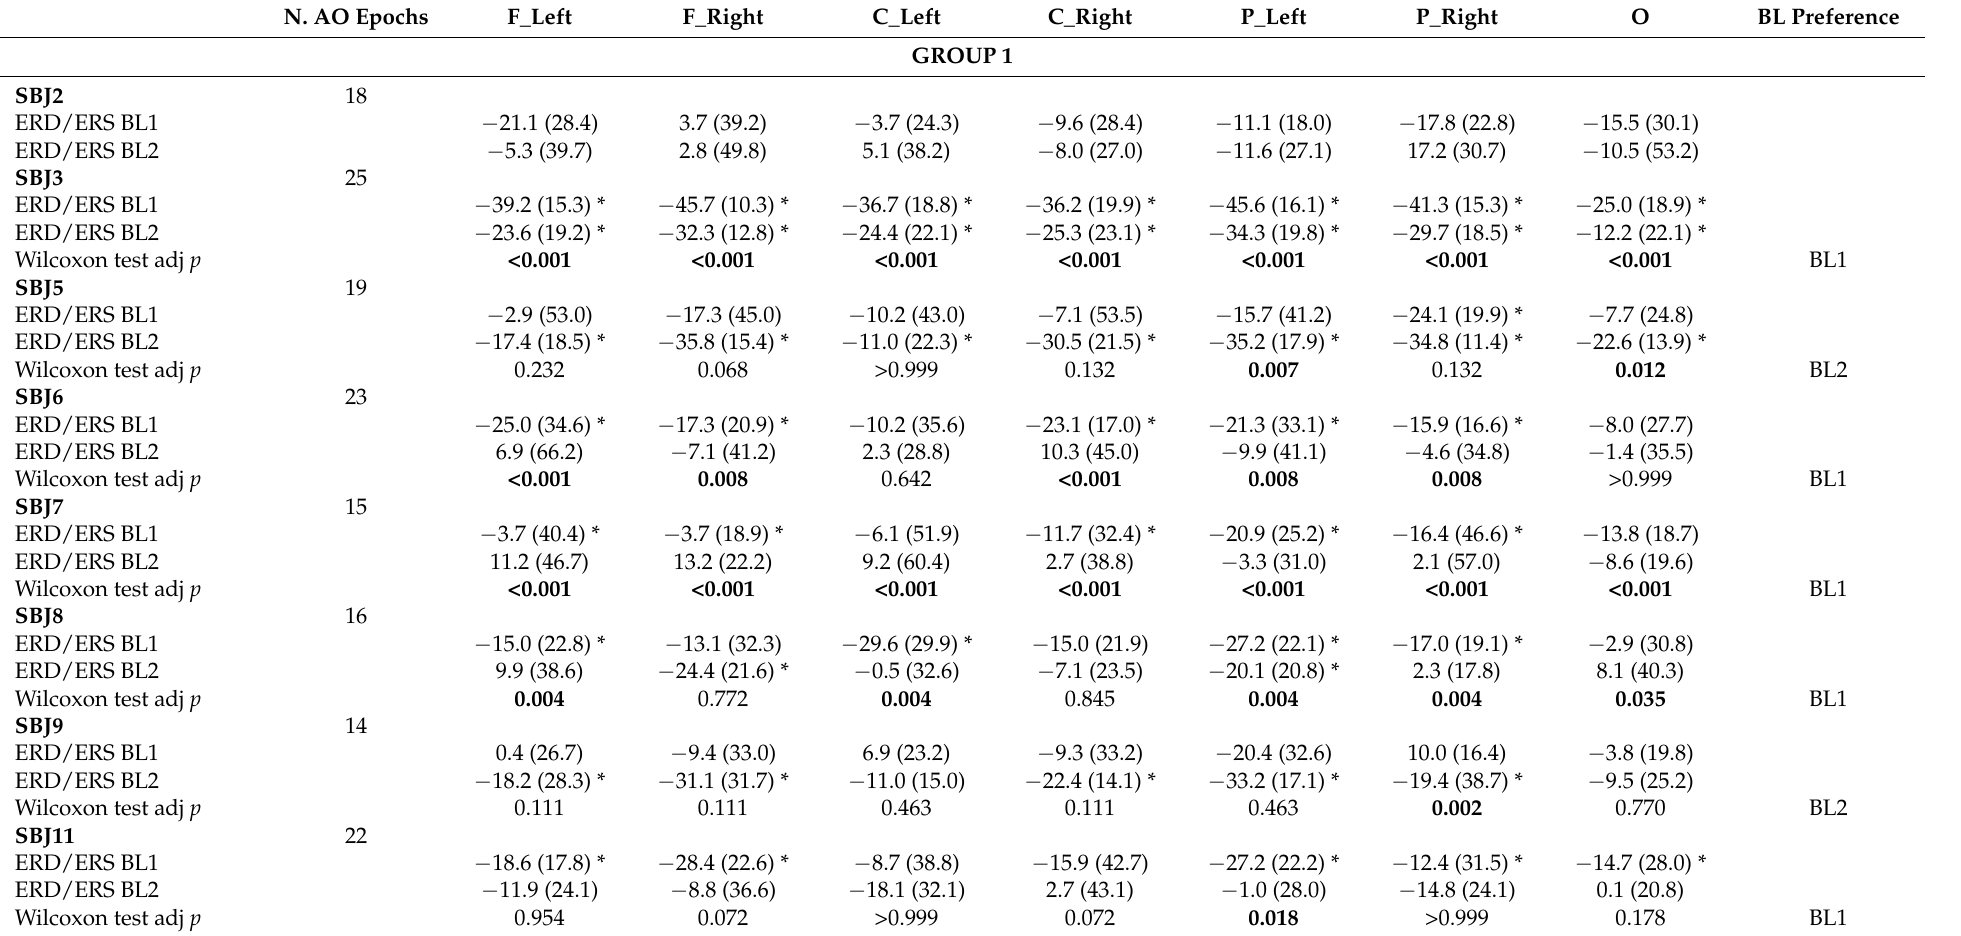
Table 3. The table shows, for each subject of the Group 1, the number of AO epochs analyzed, AO ERD/ERS values (median (IQR)) for each channel cluster and for the two baselines (BL1, BL2), the results of the paired Wilcoxon test comparing AO ERD/ERS computed with BL1 and BL2 (FCR adjusted p -value), the baseline preference. * denotes the significant